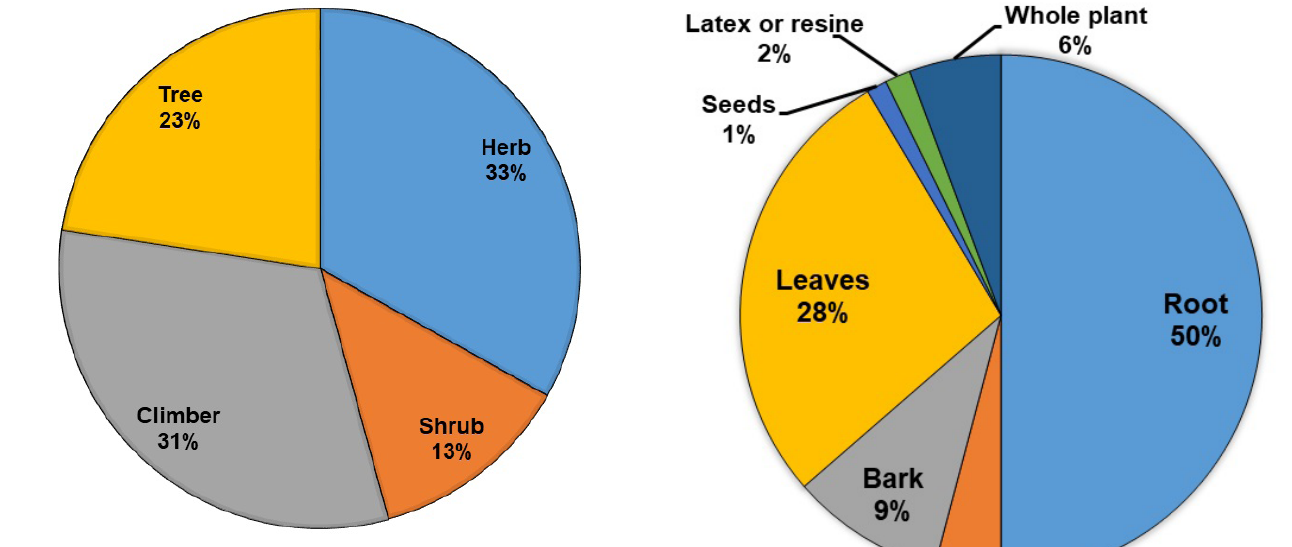
Figure 6. Distribution of ethnomedicinal plant habits used against snakebite in Ethiopia.